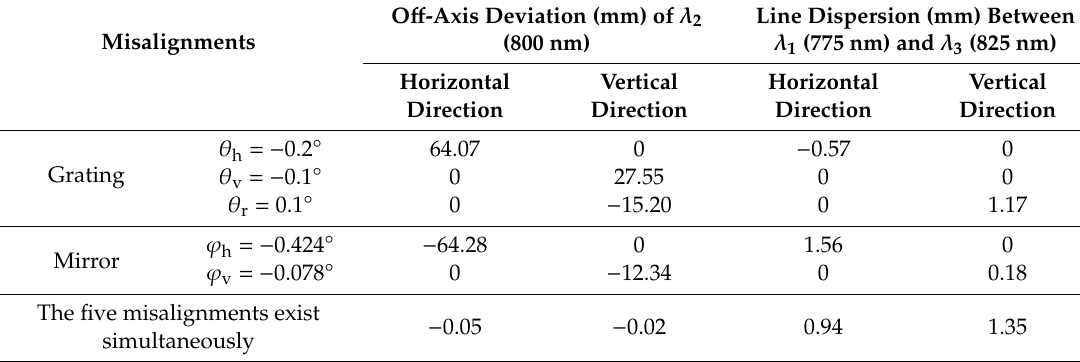
Figure 3. The line dispersion between λ 1 (775 nm) and λ 3 (825 nm) induced by each individual misalignment. ( a , b ) The horizontal tilt error and the vertical tilt error of M; ( c , e ) the horizontal tilt error, the vertical tilt error, and the rotation error of G2. H-Disp: the line dispersion in the horizontal direction; V-Disp: the line dispersion in the vertical dispersion. Table 1. The spatial characteristics of the stretched pulses caused by the misalignments when the view screen is 3.0 m away from the first grating G1 of the